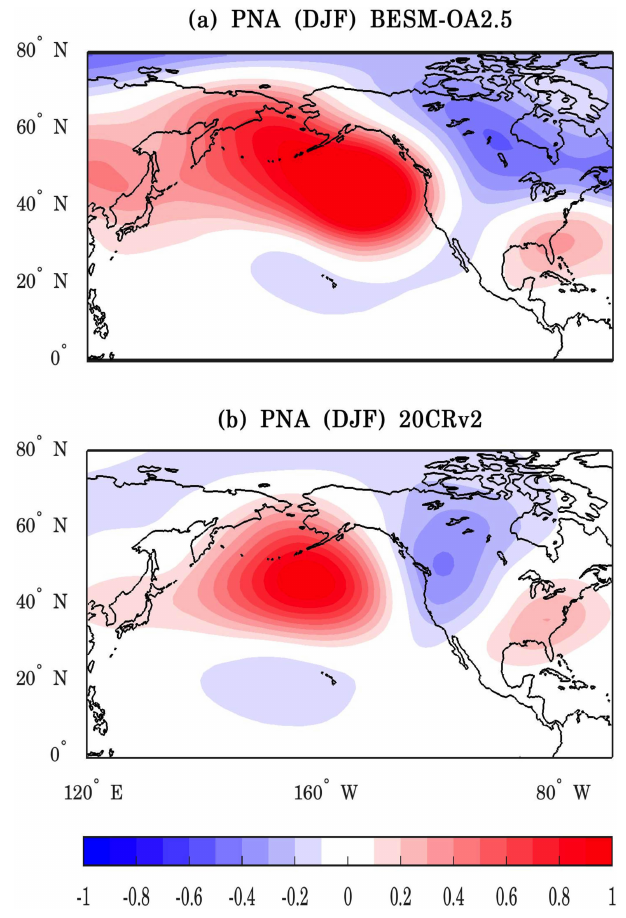
Figure 22. One-point correlation maps for (a) BESM-OA2.5 and (b) 20CRv2 reanalysis showing the correlation coefficient of 500hPa geopotential height based at 45 ◦ N, 165 ◦ W and the other grid points. The time series used were from the boreal winter sea- sonal (DJF) averaged dataset for the period